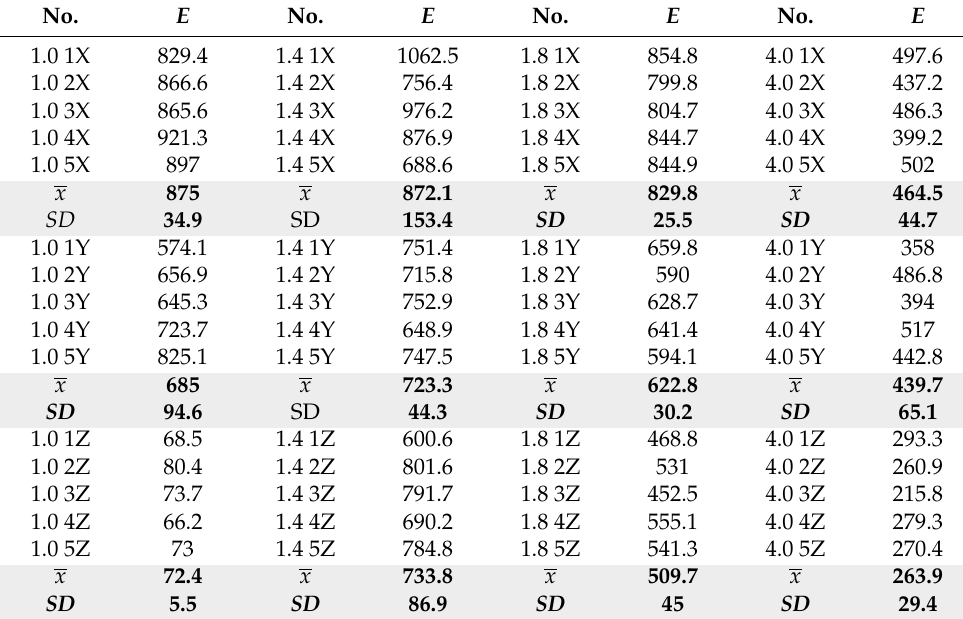
Table 6. Elasticity modulus (in MPa) for the PLA specimens.